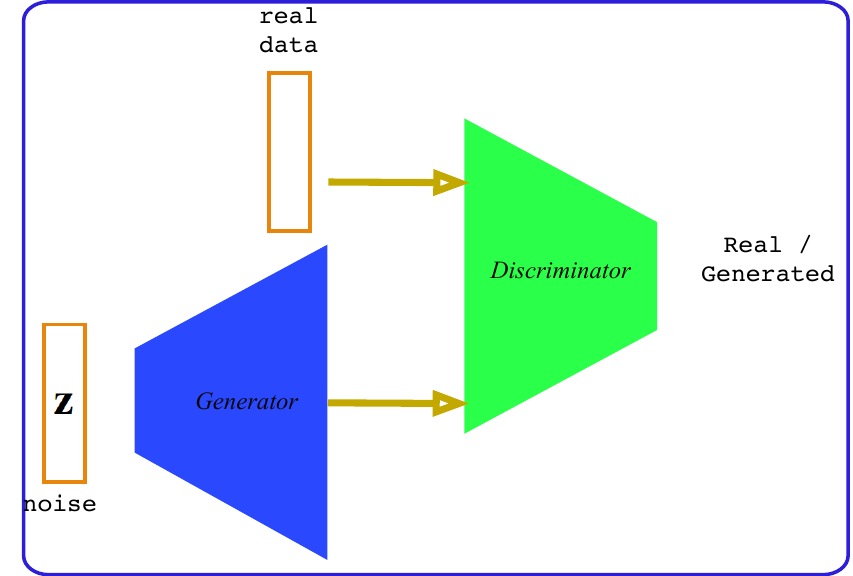
Figure 2. Illustration of the generative adversarial network